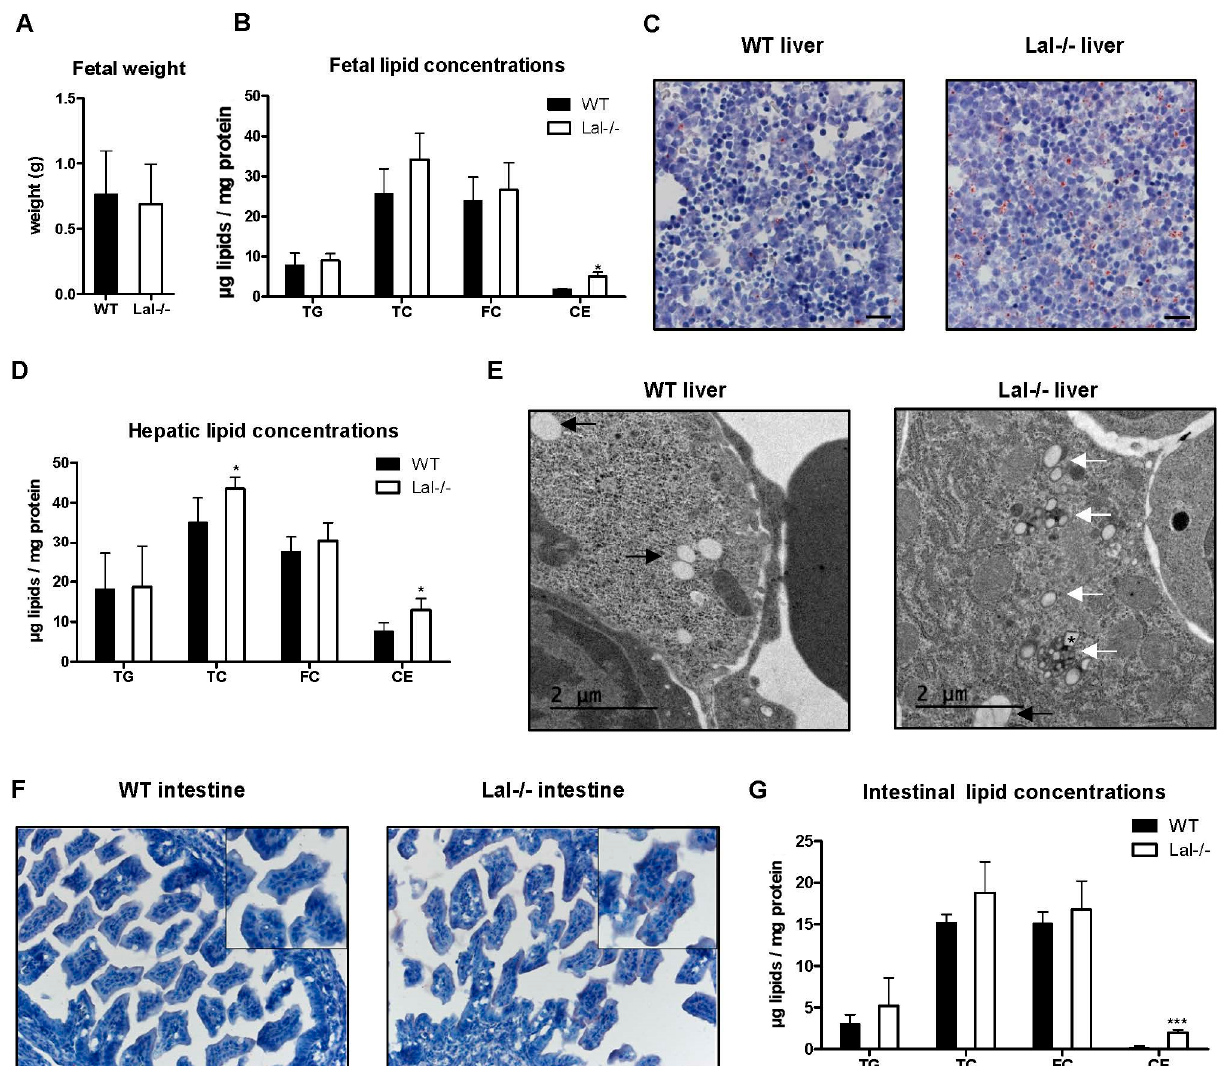
Figure 4. CE but not TG accumulation in fetal liver and intestine of Lal-/- mice. Fetuses were isolated from WT and Lal-/- mice on day 19 of pregnancy. ( A ) Fetal weight ( n = 24 WT, 34 Lal-/-) and ( B ) lipid concentrations ( n = 3 WT, 4 Lal-/-). ( C ) ORO staining of cryosections from fetal liver. Magnification, 40×; Scale bar, 20 µm. ( D ) Fetal hepatic lipid levels ( n = 4). ( E ) Electron micrographs of fetal liver; white arrows indicate lipid-filled lysosomes, black arrows indicate cytosolic lipid, * indicates CE crystal. ( F ) ORO staining of cryosections from fetal intestine. Magnification, 20×; Scale bar, 50 µm. ( G ) Fetal intestinal lipid levels ( n = 3–5). Data represent mean values + SD. Statistically significant differences were calculated by two-tailed Student’s t -test; * p < 0.05, *** p ≤ 0.001.